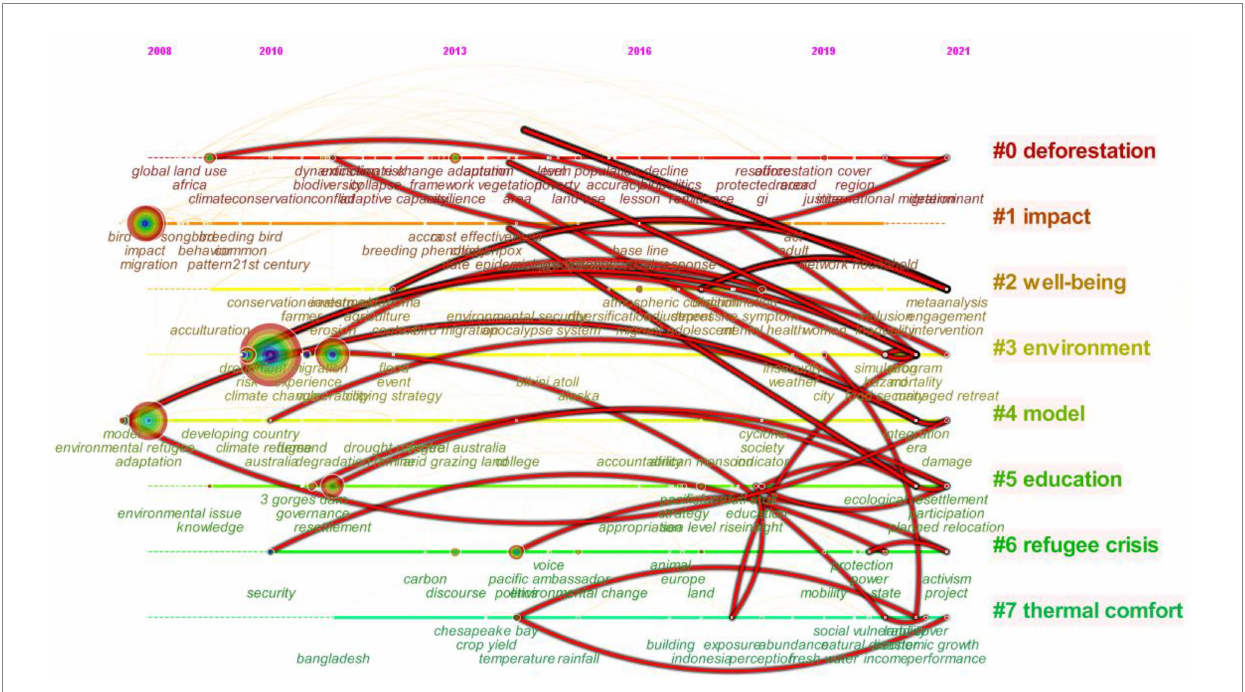
FIGURE 8 Evolution map of the relationship between keywords of climate migration (WOS 2008–2021).